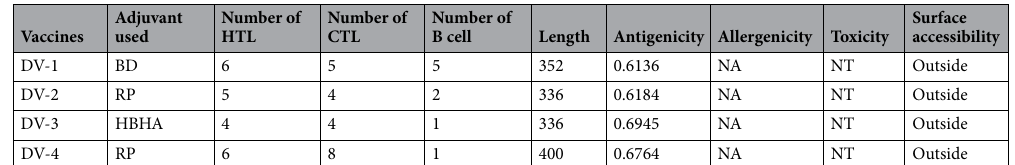
Table 8. Composition and assessment of the primary sequence of the multi-epitope based vaccine construct. BD beta defensing, RP ribosomal protein, HBHA Heparin-binding hemagglutinin; NA non-allergen, NT non-